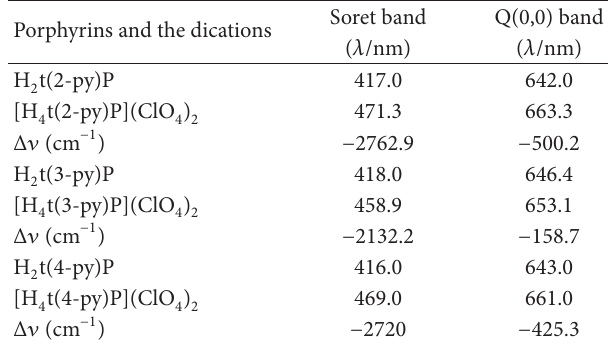
t(py)P with T 4: UV-vis spectral data for the dications of H 2 in CH Cl 2a . HClO 4 2 Porphyrins and the